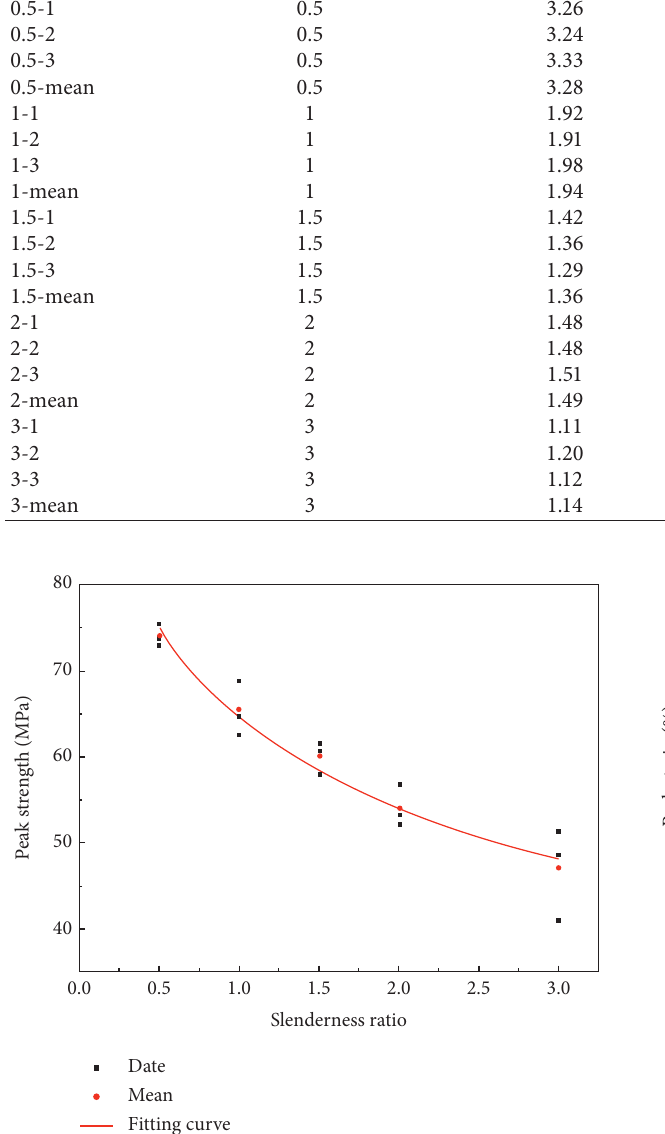
Figure 4: The peak strain versus the slenderness ratio ( D